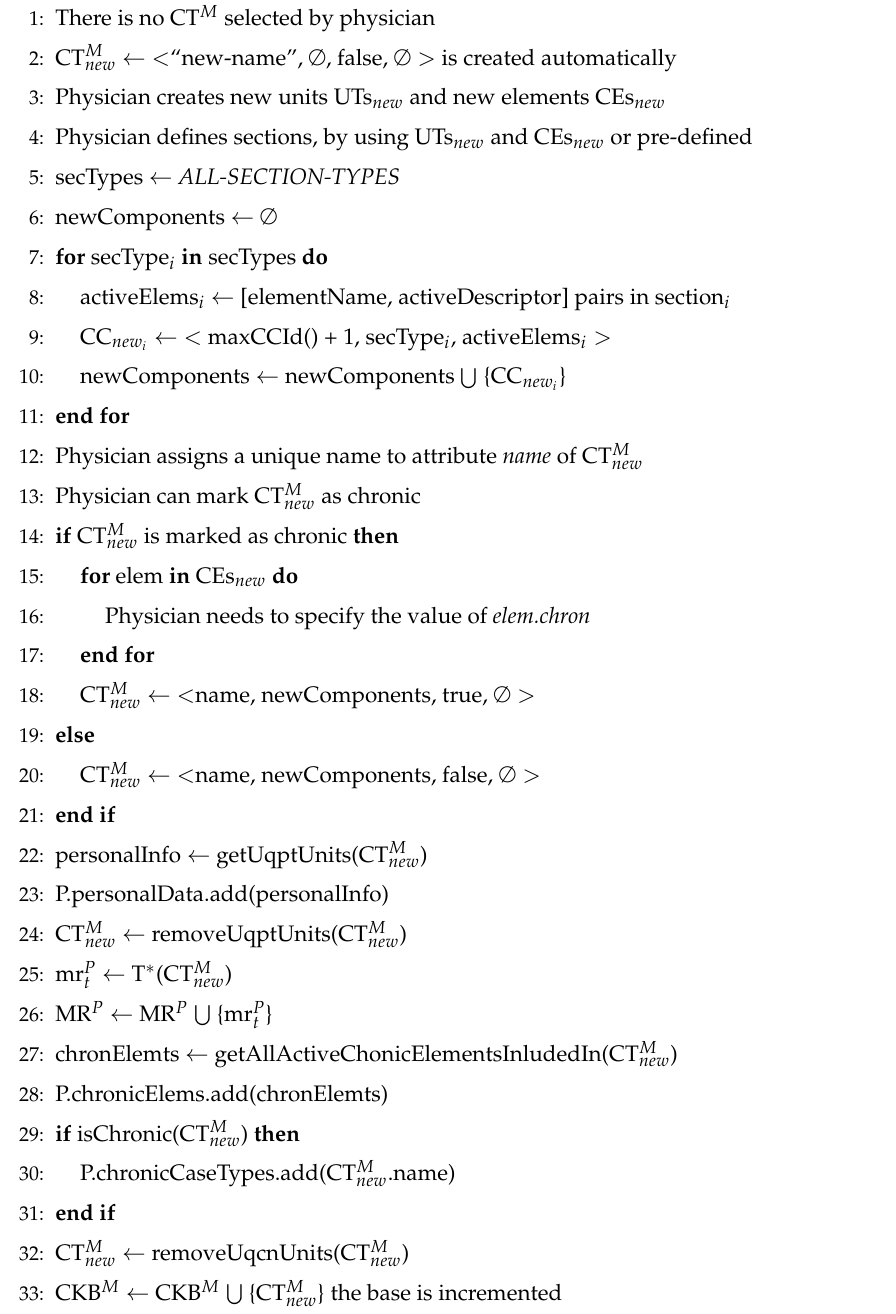
Algorithm 6 New case type flow for the attention of patient